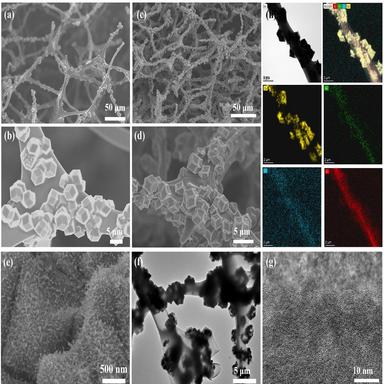
SEM images of (a-b) MF@ZIF67, (c-e) MF@Co/NC-900; (f) TEM image, (g) HRTEM image of CMF@Co/NC-900; and (h) TEM-EDS elemental mapping of CMF@Co/NC-900.